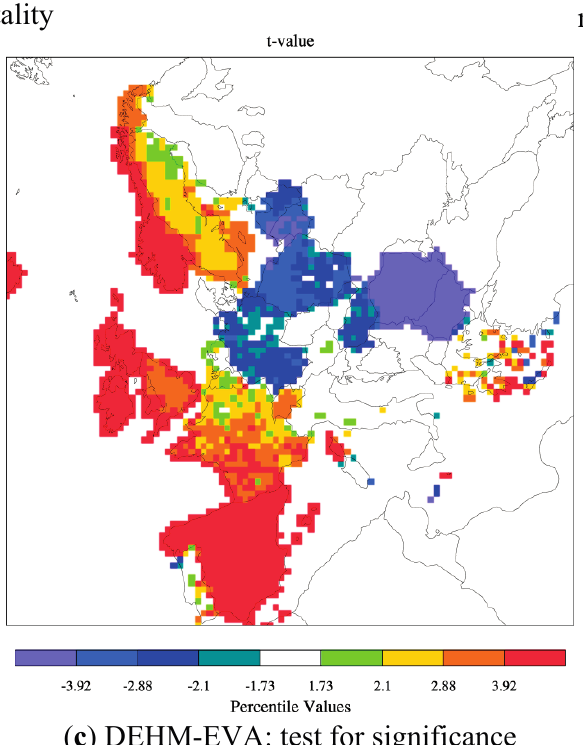
Figure 10. Changes in population: the absolute difference ( a ) and the change in % ( b ) of acute mortality when using the 2050 population data in the assessment for 2050 instead of the population data for 2000. The change has been tested for significance and the corresponding t -value is given in ( c ). Only in areas with a colour different from white (in panel c) the estimated difference is significant. Based on the DEHM-EVA results. The threshold value for significance is chosen to